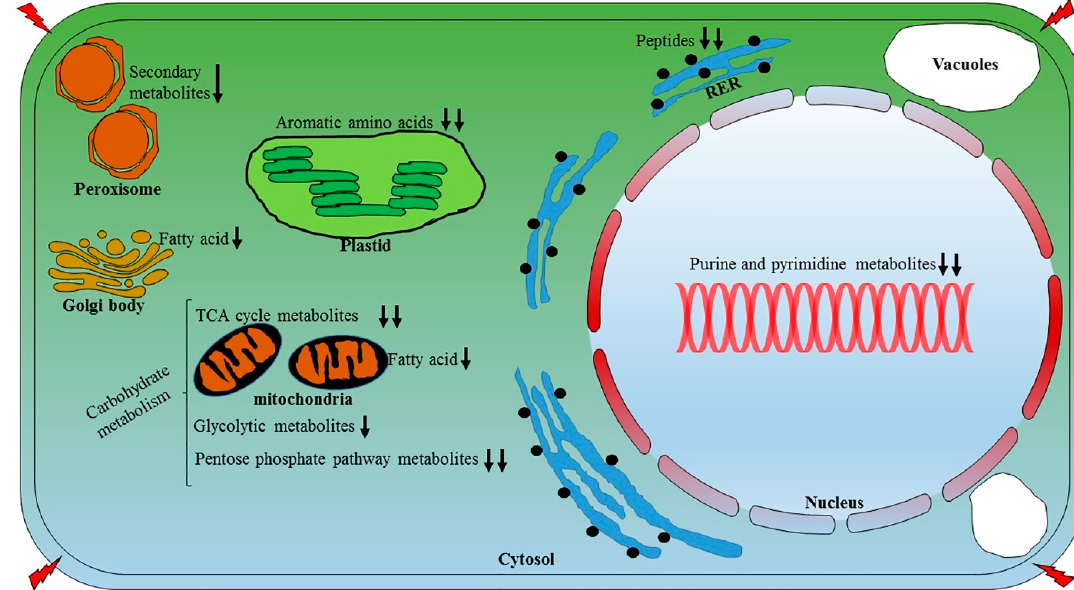
Figure 8. A proposed model shows the metabolomic responses of soybean leaves during heat stress. The figure shows the effects of heat stress on key metabolites in key cell organelles. Single and double downward-pointing arrows (based on scaled quantity of metabolites) indicate metabolites reduced due to heat stress. There was no metabolite found in this investigation that showed increased abundance during heat stress. The red lightning arrows on the corners of the cell represent heat stress.